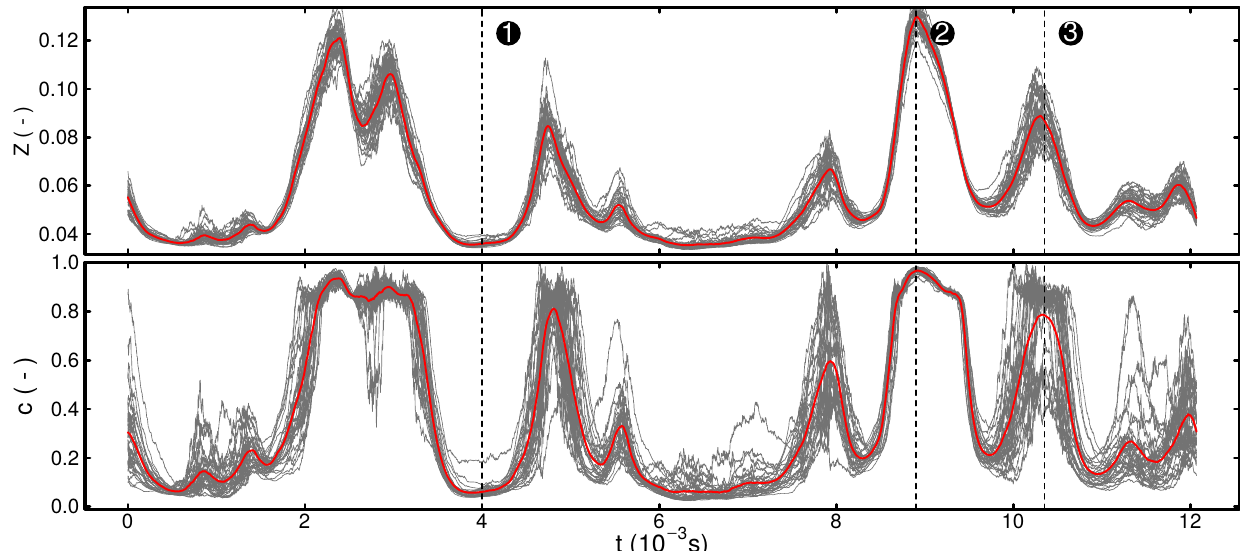
Figure 8. Temporal evolution of mixture fraction ( top ) and normalized progress variable ( bottom ) stochastic fields (grey lines) alongside their respective first moment, i.e., their arithmetic mean (red lines). The probe is located at the centerline, 20 diameters downstream of the burner exit plane. The position is displayed in Figure 2. The vertical dotted lines indicate three representative time instants, which will be discussed